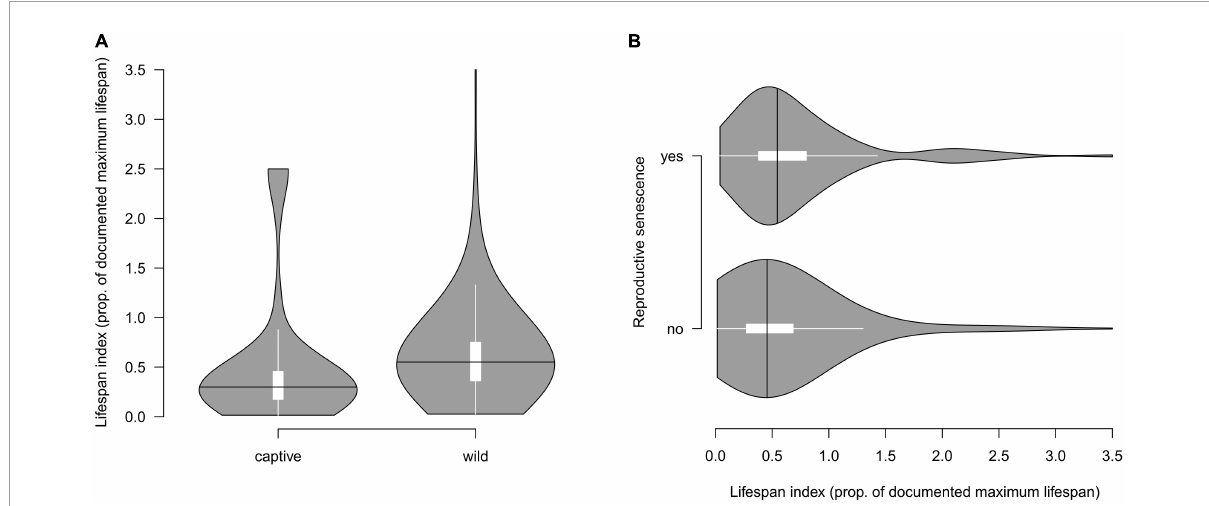
FIGURE2 The coverage of species-specific maximum lifespans. The lifespan index is a ratio between the study’s maximum age and documented species’ lifespan. (A) Distribution of lifespan index in records from captive and wild populations. (B) Relationship between lifespan index and confirmed reproductive senescence. The width of the violin plots illustrates the density of the data points, the white inset box represents the interquartile range and the black crossing line indicates the median of the lifespan index. Note that the age reported in some studies exceeded the maximum known age for the species (retrieved from FishBase, Froese and Pauly,